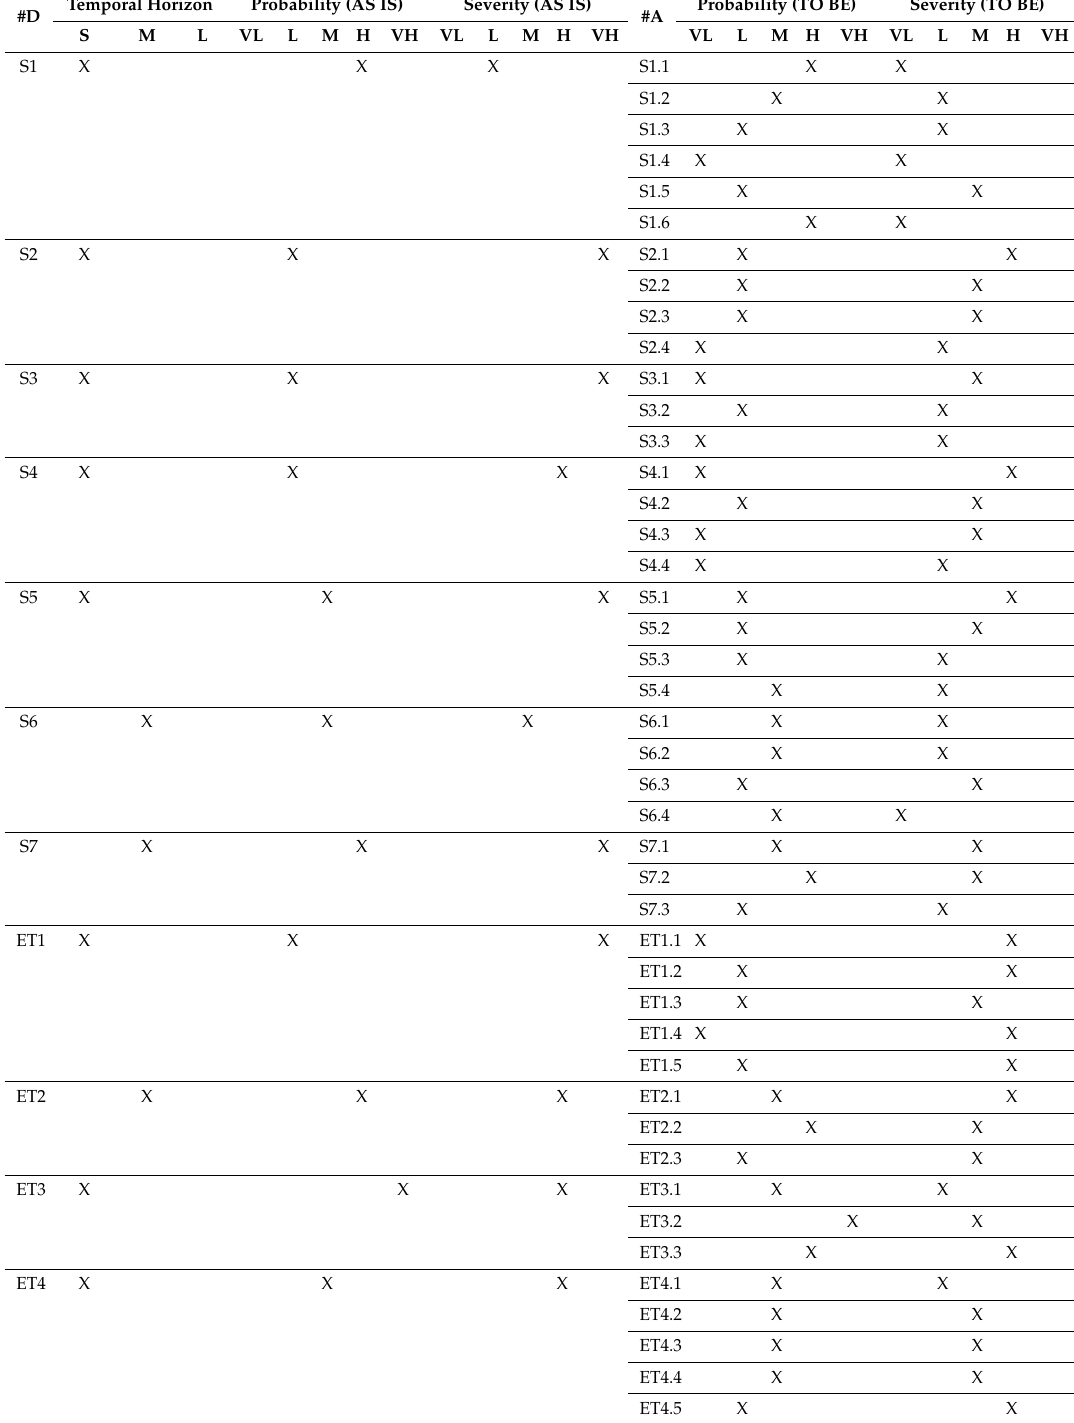
Table A1. Data related to the company’s questionnaire responses (temporal horizon: short (S)—1 year; medium (M)—5 years; long (L)—10 years; probability / severity: very high (VH), high (H), medium (M), low (L), and very low